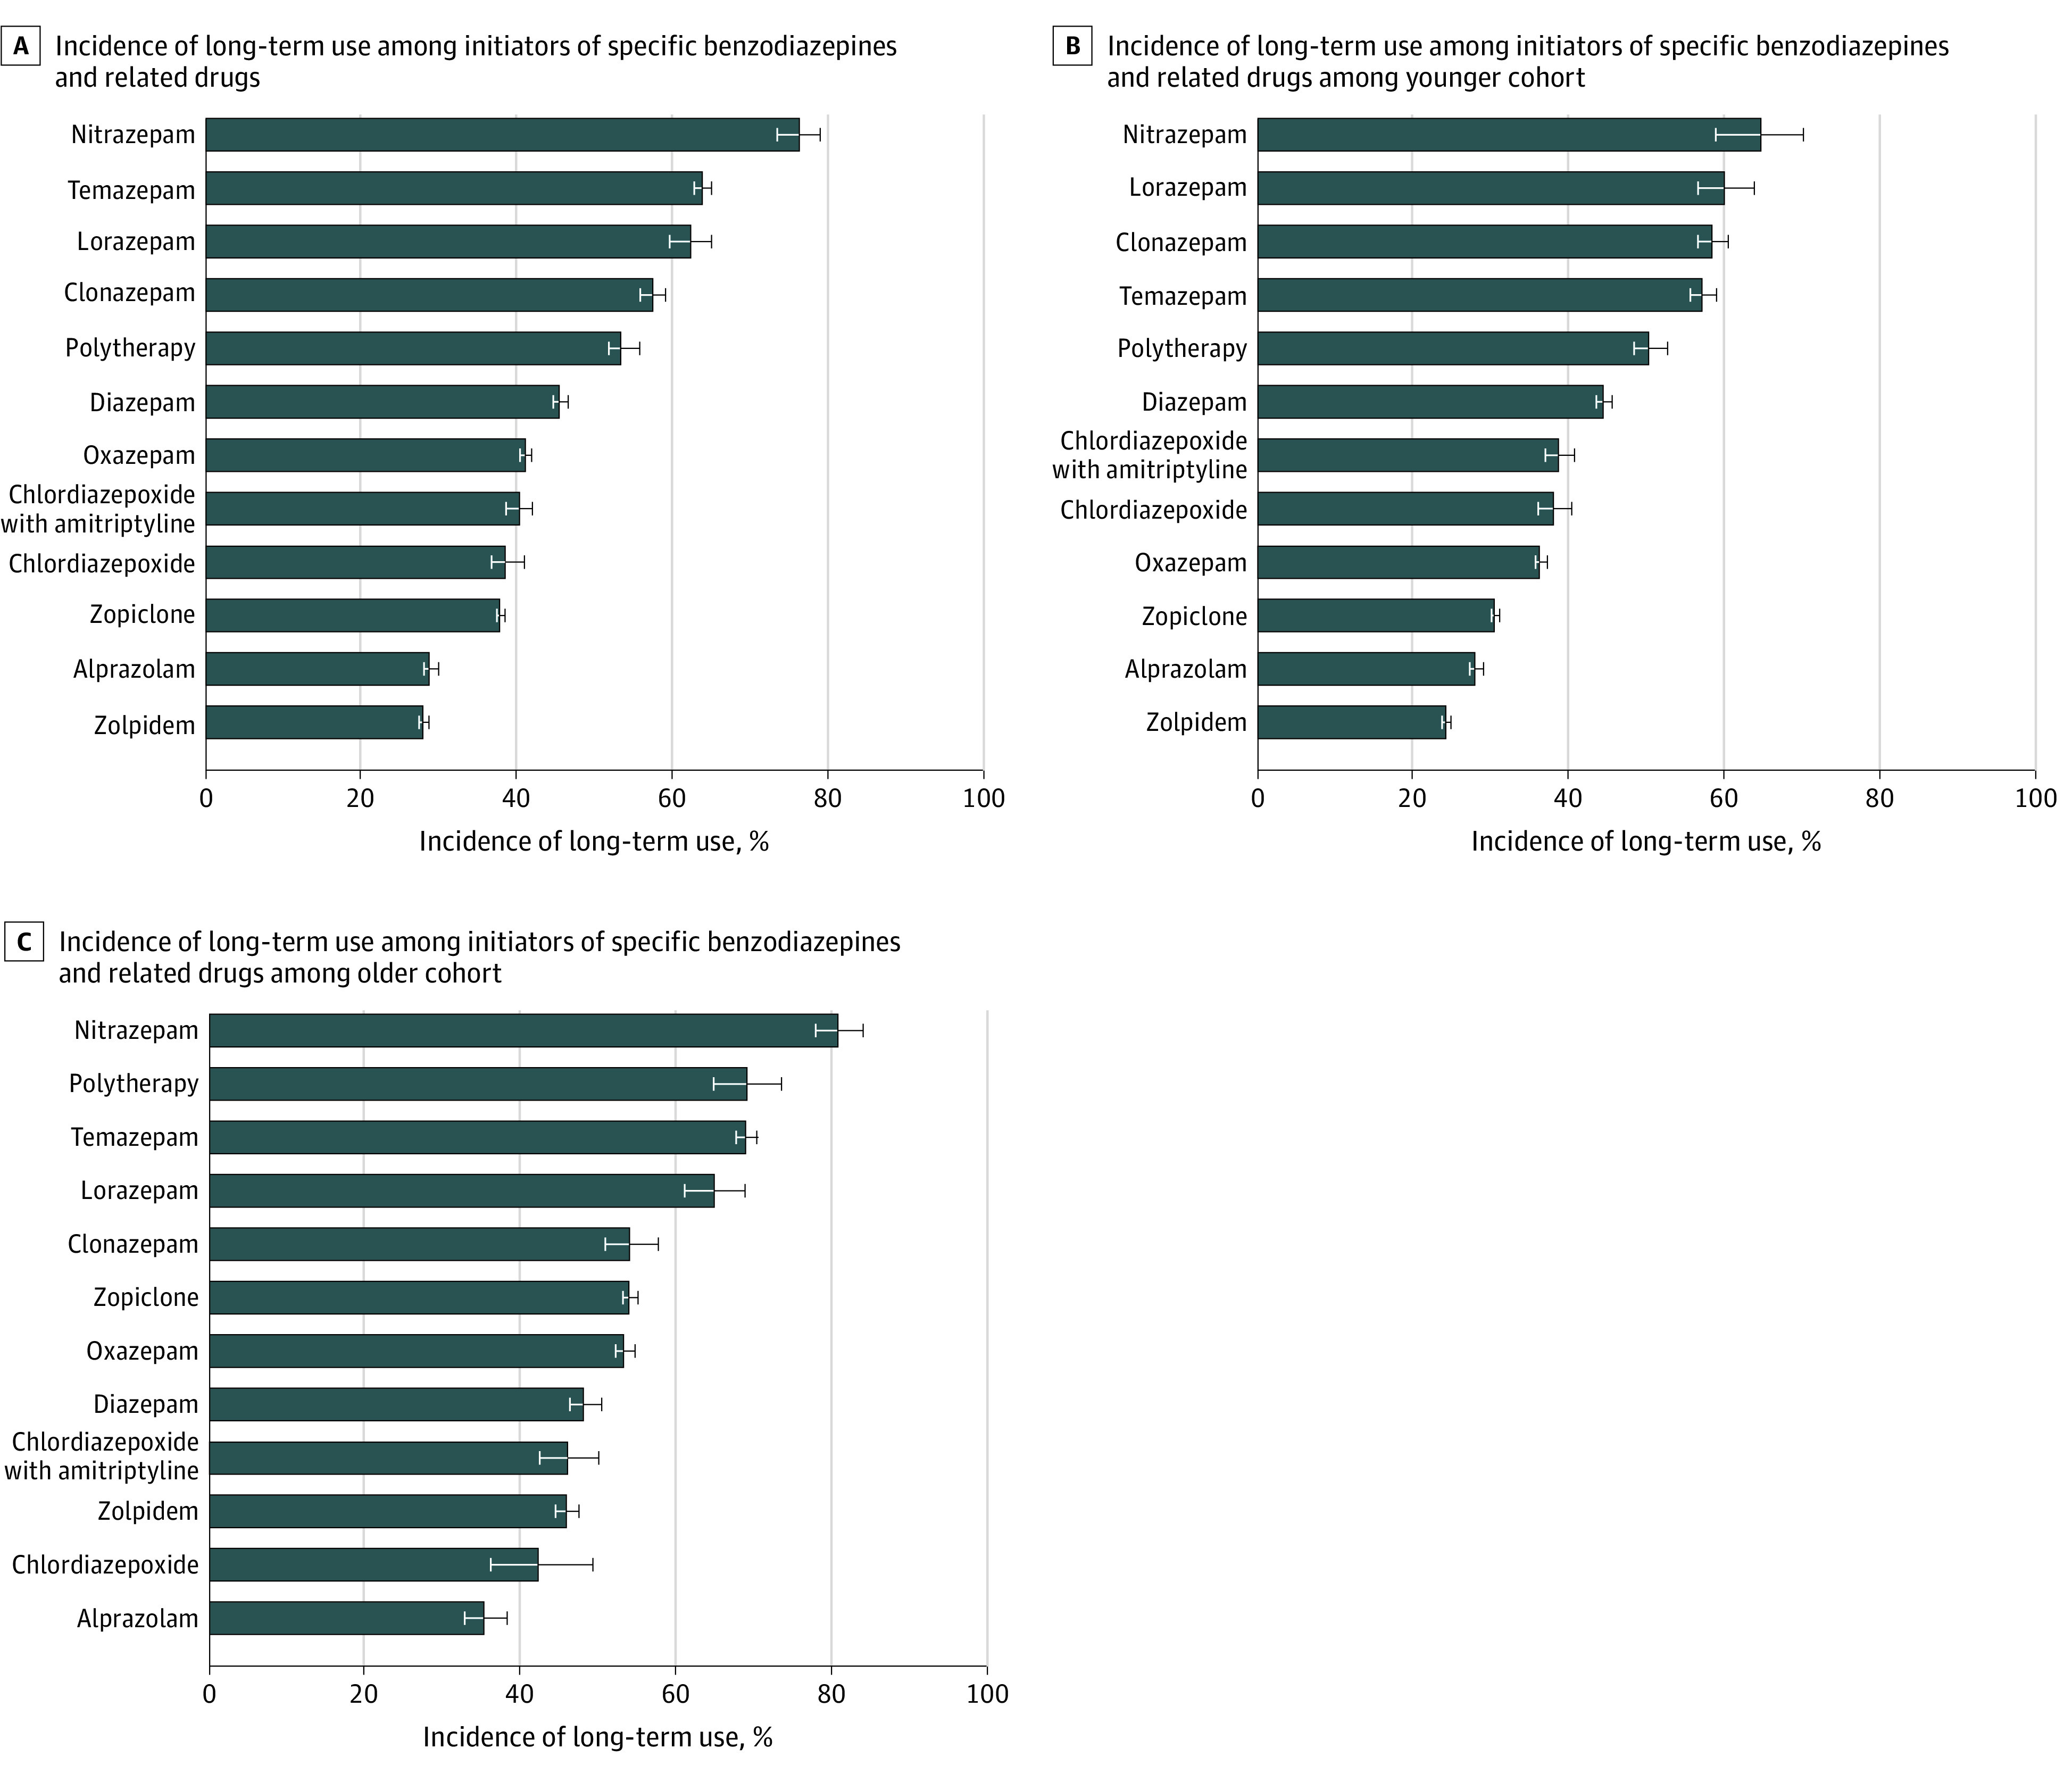
Incidence of Long-term Use Among Initiators of Treatment With Specific Benzodiazepines and Related Drugs During Follow-upError bars indicate 95% CIs.